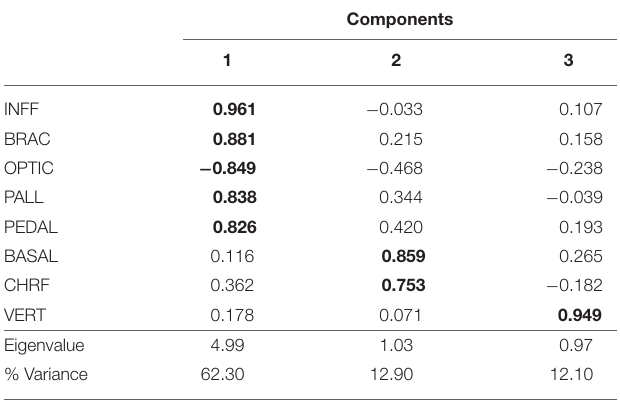
TABLE 2 | Principal components analysis for the relative proportions of the eight brain-functional sets (for abbreviations and description see Supplementary Table 2 ) of the 78 species of cephalopods considered in this study (see also Borrelli, 2007).